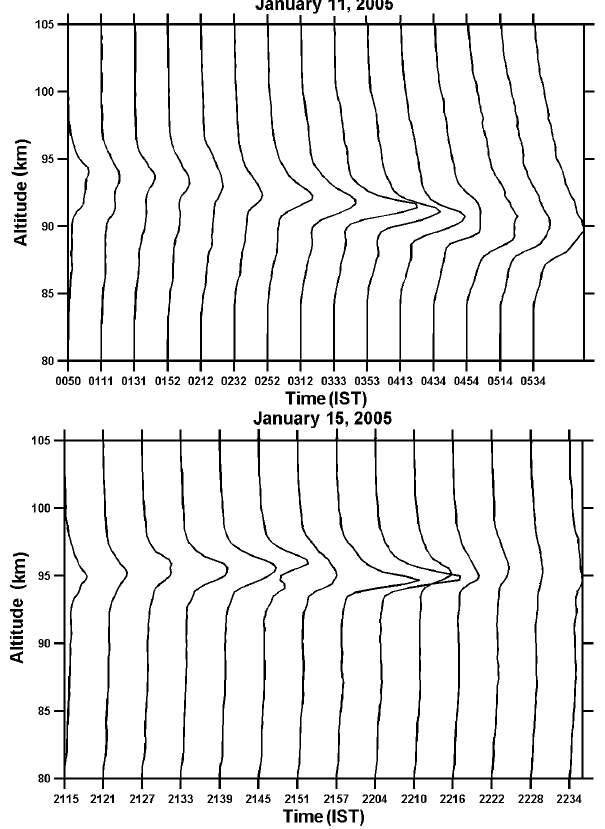
Fig. 3. Successive profiles of sodium density showing evolution and decay of an SSL event on 11 January 2005 (top panel) and 15 January 2005 (bottom